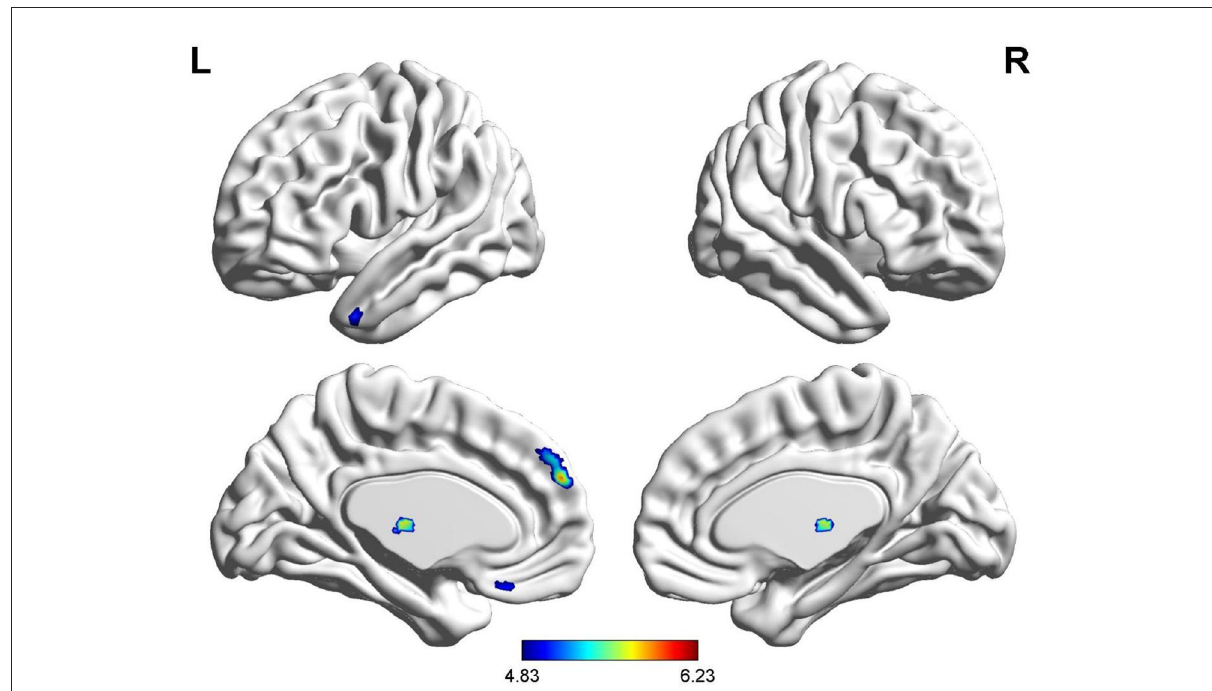
FIGURE1 Brain regions with a significantly decreased volume of gray matter in anti-NMDAR encephalitis patients compared to healthy